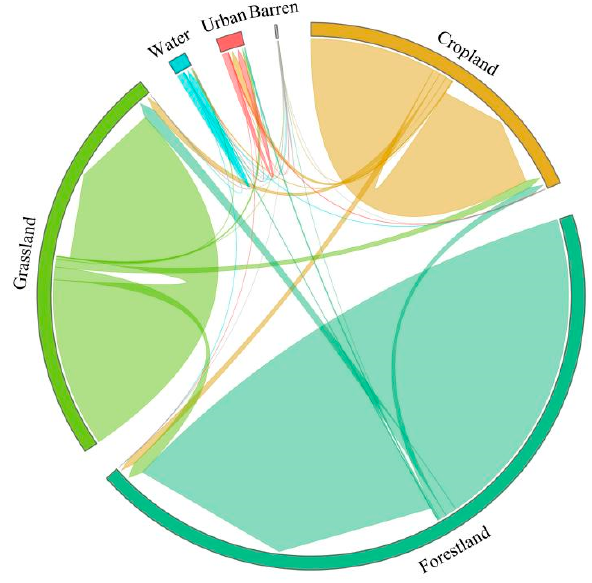
Figure 6. Map of land transfer flow from 1980 to 2020.